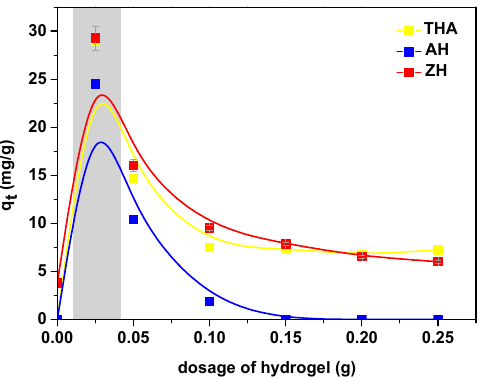
Figure 1. Effect of dosage of hydrogel on the sorption capacity for the Mn(II) complexes with EDDS on AH, ZH and THA (initial concentration 1 × 10 − 3